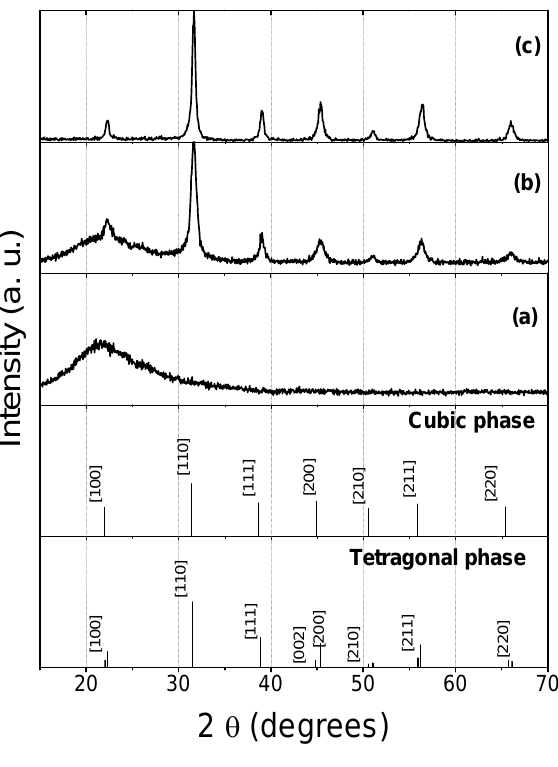
Figure 5. XRD patterns of BaTiO calcined at 700 °C